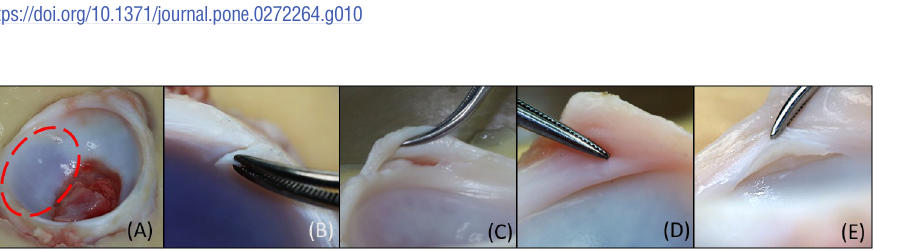
Fig 11. Types of acetabular damage observed following during simulations. (A) Cartilage blushing, (B) Labral tear, (C) Large labral tear, (D) Initial chondrolabral junction separation, (E) Large labral tear and chondrolabral junction separation.